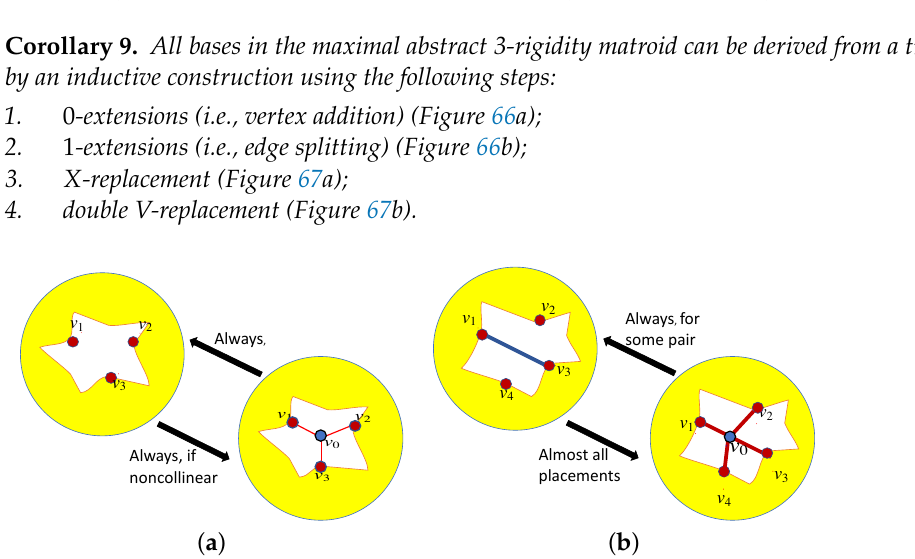
independent sets. 2